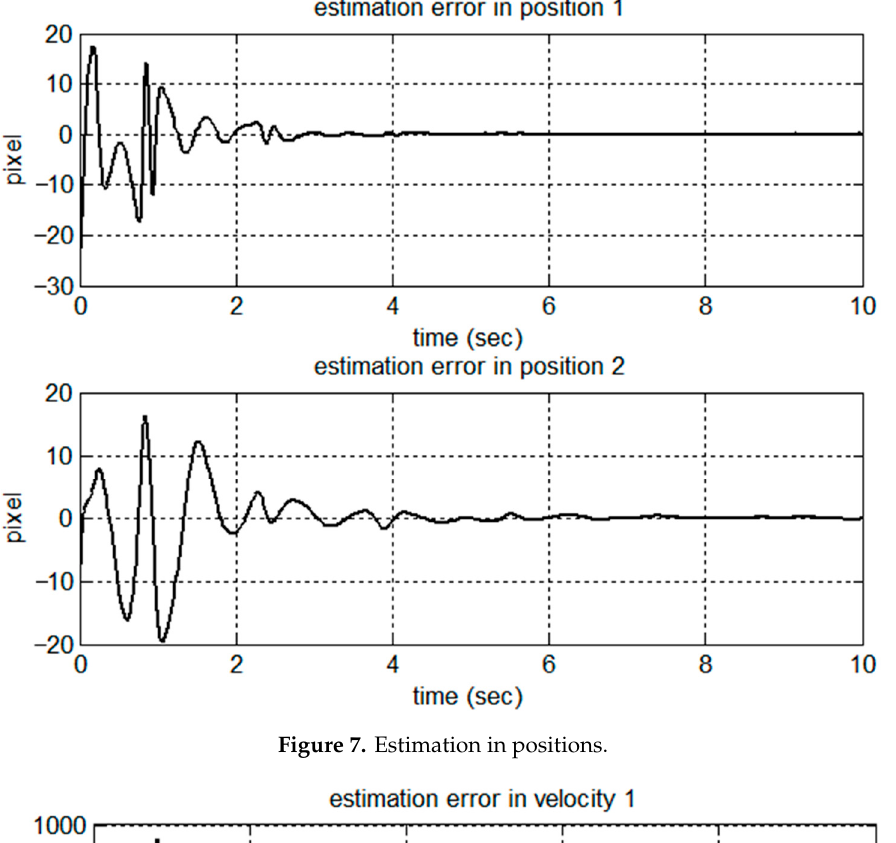
Figure 7. Estimation in positions.